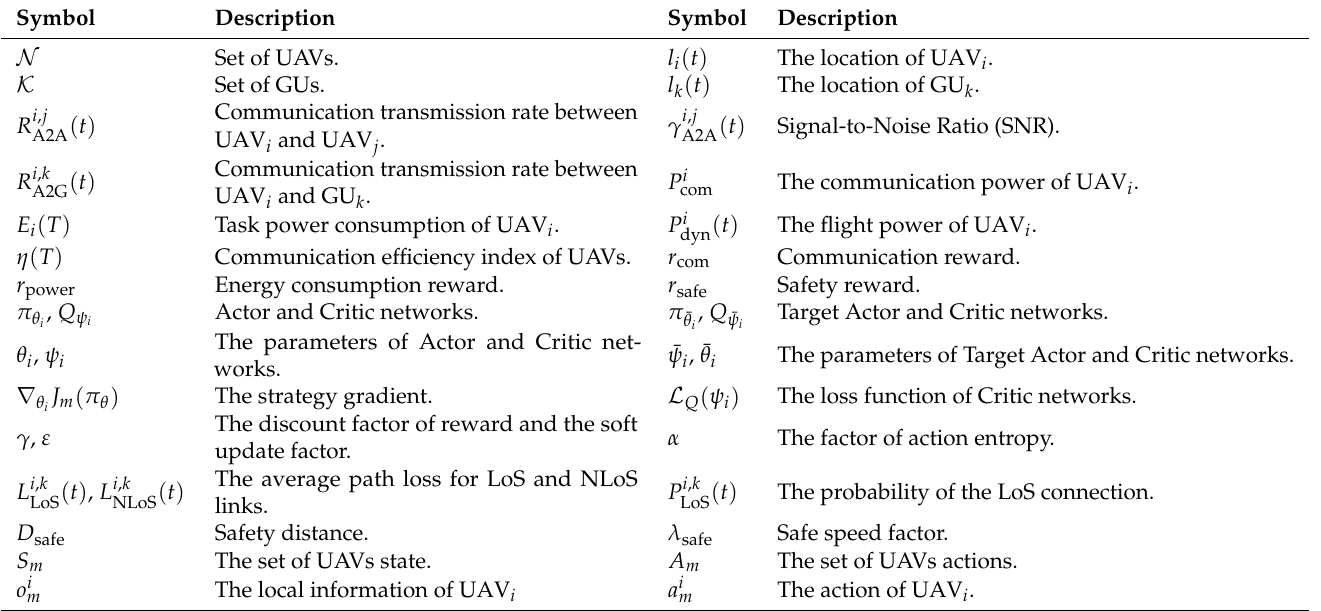
Table 1. Table of Important